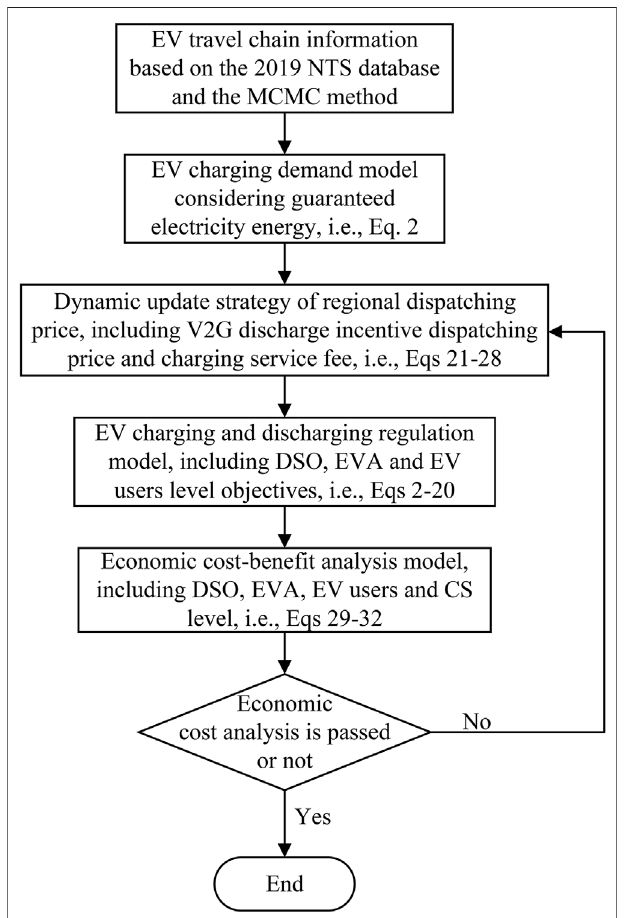
FIGURE 4 | Strategy development fl